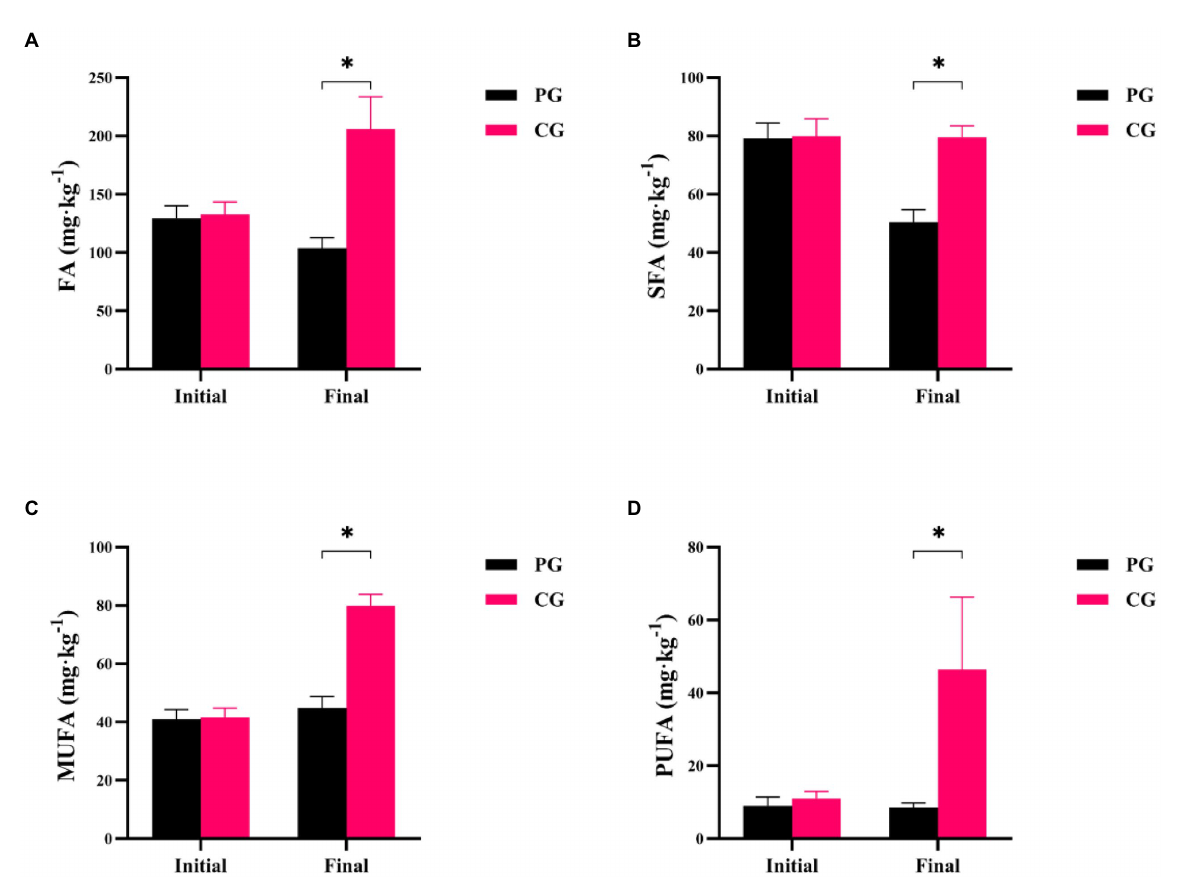
FIGURE 2 Differences in sedimentary fatty acids between PG and CG groups during the experimental period, including FA (A) , SFA (B) , MUFA (C) , and PUFA (D) . “Initial” and “Final” indicate the initial and final stages of the experimental period, respectively. * indicates a significant difference between PG and CG groups ( p < 0.05).